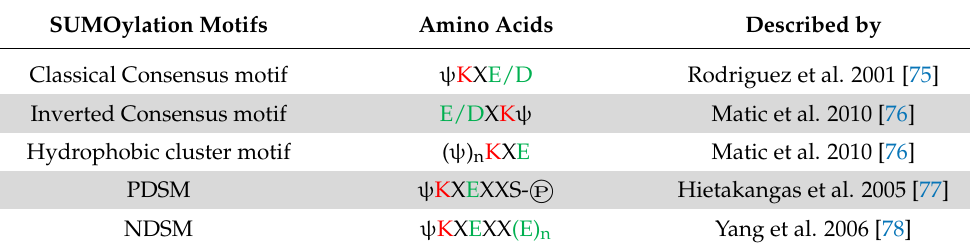
Table 2. The different SUMOylation